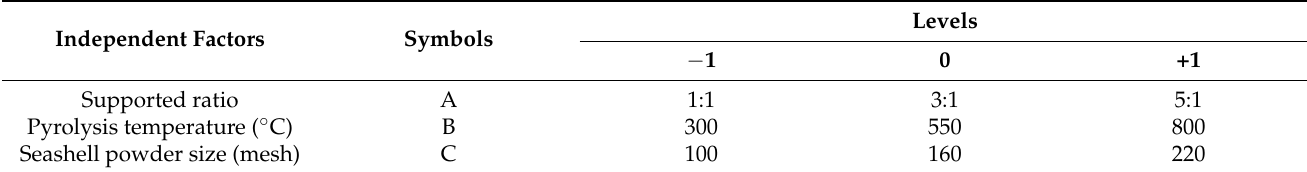
Table 1. Experimental ranges and levels of independent variables.